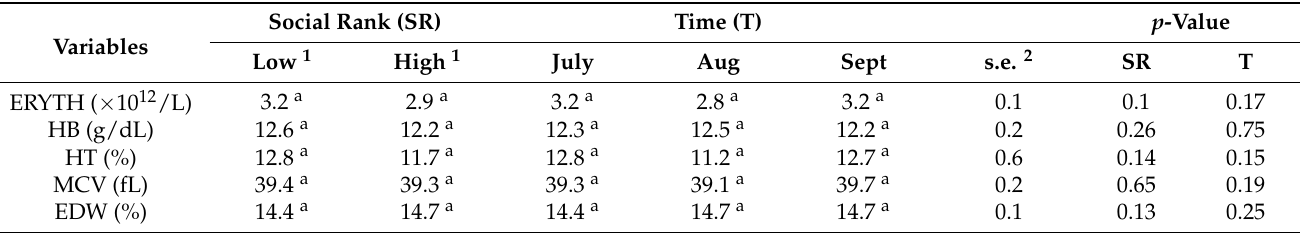
Table 6. Least square means ± standard error according to social rank (SR) and time (T) (i.e., single effects) for the hemogram response variables of erythrocytes (ERYTH), hemoglobin (HB), hematocrit (HT), mean corpuscular volume (MCV), and erythrocyte distribution width (EDW) in Dorper rams ( n = 24) in northern Mexico (25 ◦ N) 1,2